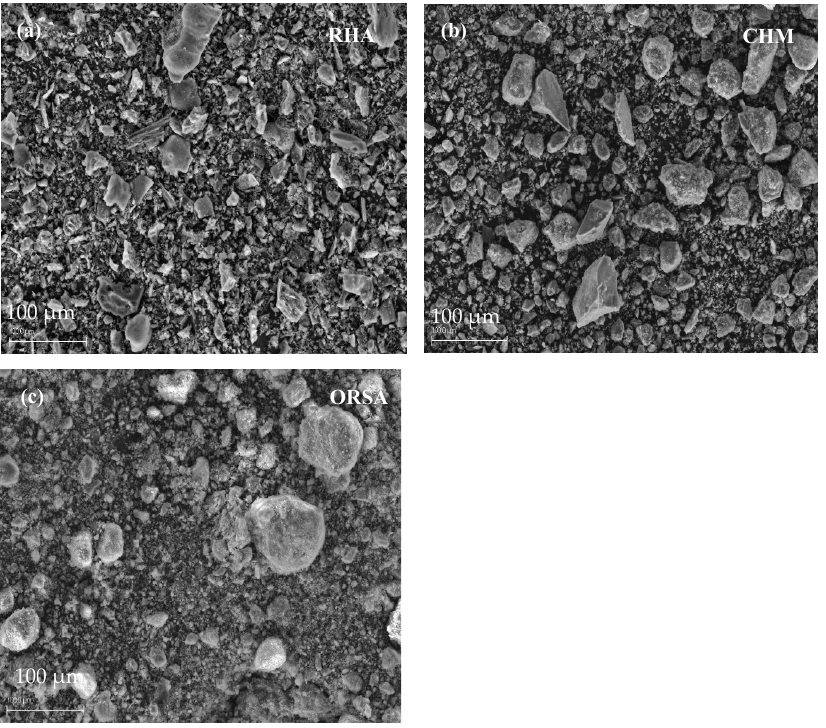
Figure 4. SEM micrographs of raw materials: ( a ) rice husk ash (RHA); ( b ) chamotte (CHM) and ( c ) oil refining sludge ash (ORSA) .